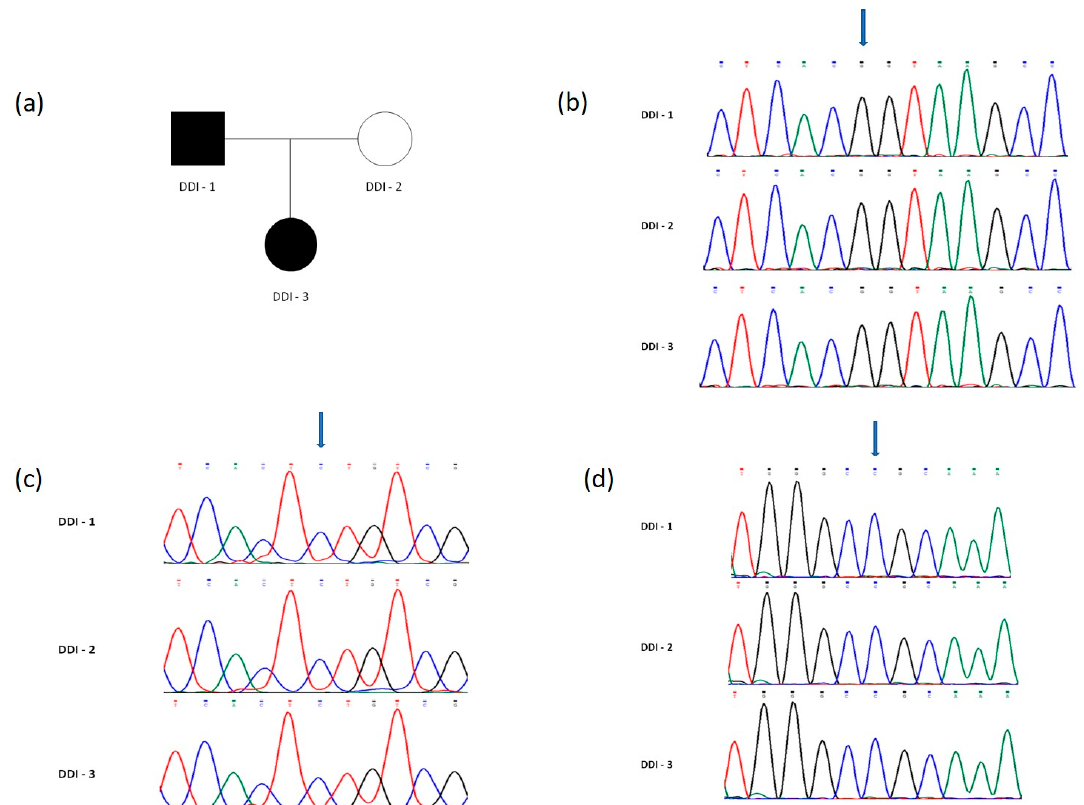
Figure 13. ( a ) Pedigree of the family. Affected subjects are denoted in black. DDI-3 is the proband. ( b – d ) DNA sequence chromatograms obtained from Sanger sequencing revealing normal status of ( b ) the c.84 + 1G > T mutation in the SMOC2 gene, ( c ) the IVS7 + 46C > G mutation in the VPS4B gene and ( d ) the c.353C > A mutation in the SSUH2 gene, in all three family members (DDI-1, DDI-2 and DDI-3). Mutation sites previously reported are indicated by blue arrows.